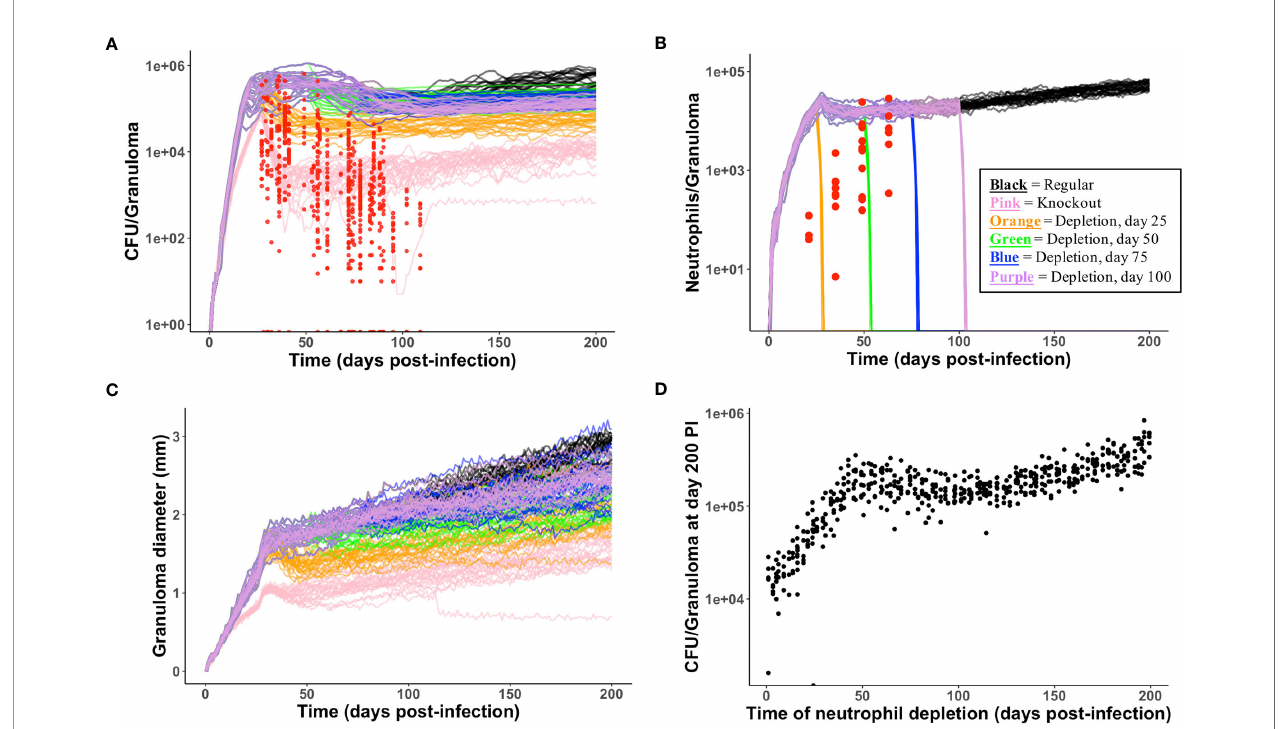
FIGURE 6 | Temporal outcomes for virtual neutrophil deletion and depletion studies. (A – C) show temporal simulated data for the six virtual experiments (control, neutrophil deletion, and four temporally-distinct neutrophil depletions). Each simulated data set contains 25 granulomas, one of which is shown in Figure 5 . The color key is shown in (B). (A) CFU versus days PI. Red = experimental data from NHPs. We observe that deleting or depleting neutrophils reduces total CFU at day 200. (B) Neutrophil cell counts versus days PI are shown. Neutrophil count quickly goes to zero following neutrophil depletion. (C) We observe that deleting or depleting neutrophils reduces granuloma diameters at day 200. (D) Using the control parameter set, we varied the time PI of neutrophil depletion. At day 200, reduced CFU correlates with earlier neutrophil depletion PI.